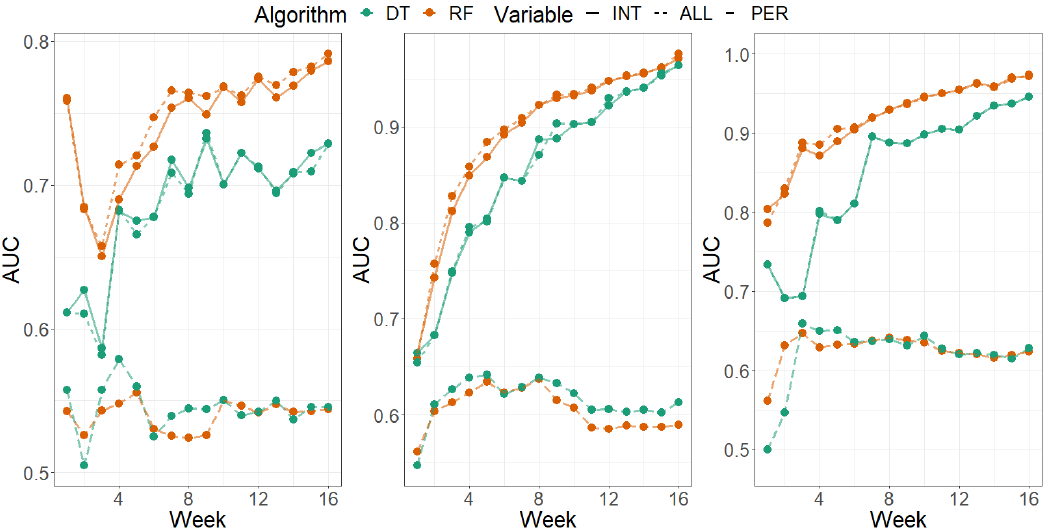
Figure 7. Evolution of the predictive power when predicting ( a: left ) dropout related to activity, ( b: middle ) dropout related to completion and ( c: right ) success.